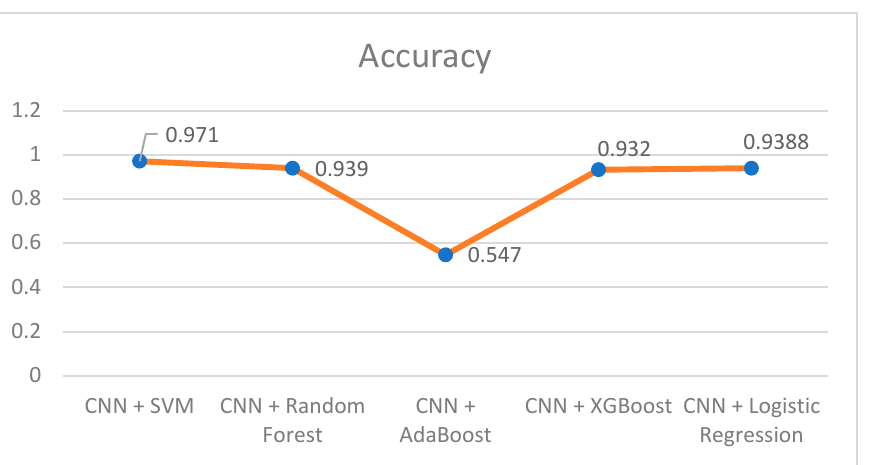
Figure 9. The accuracy of the hybrid models on the MNIST dataset.